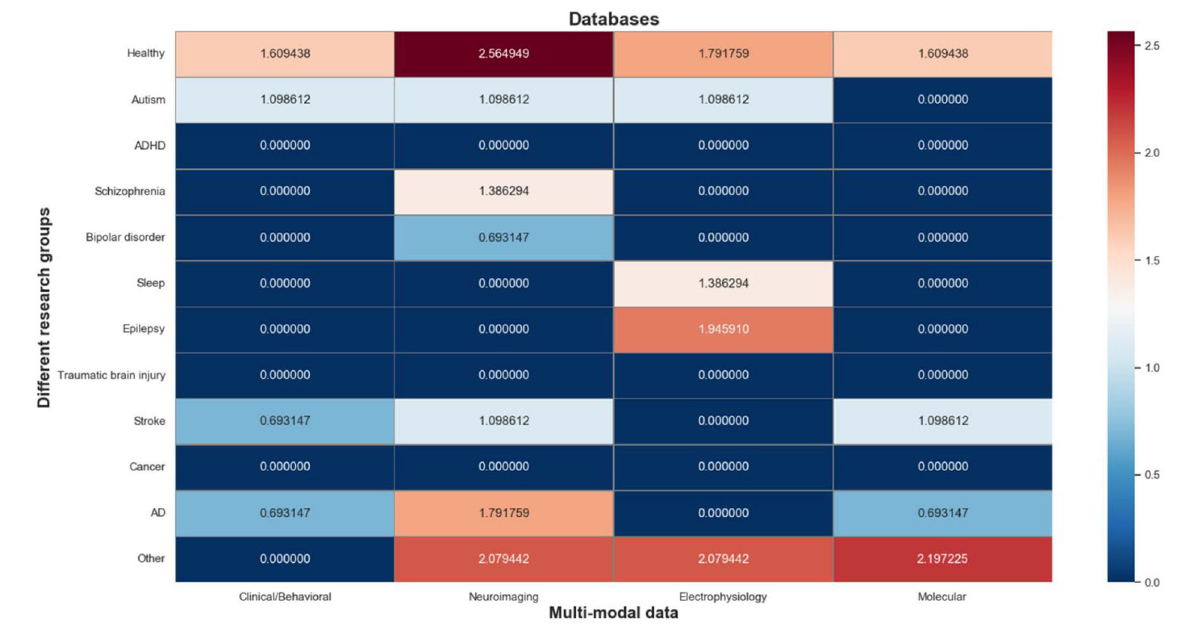
FIGURE6 Heat map of multi-modal databases.